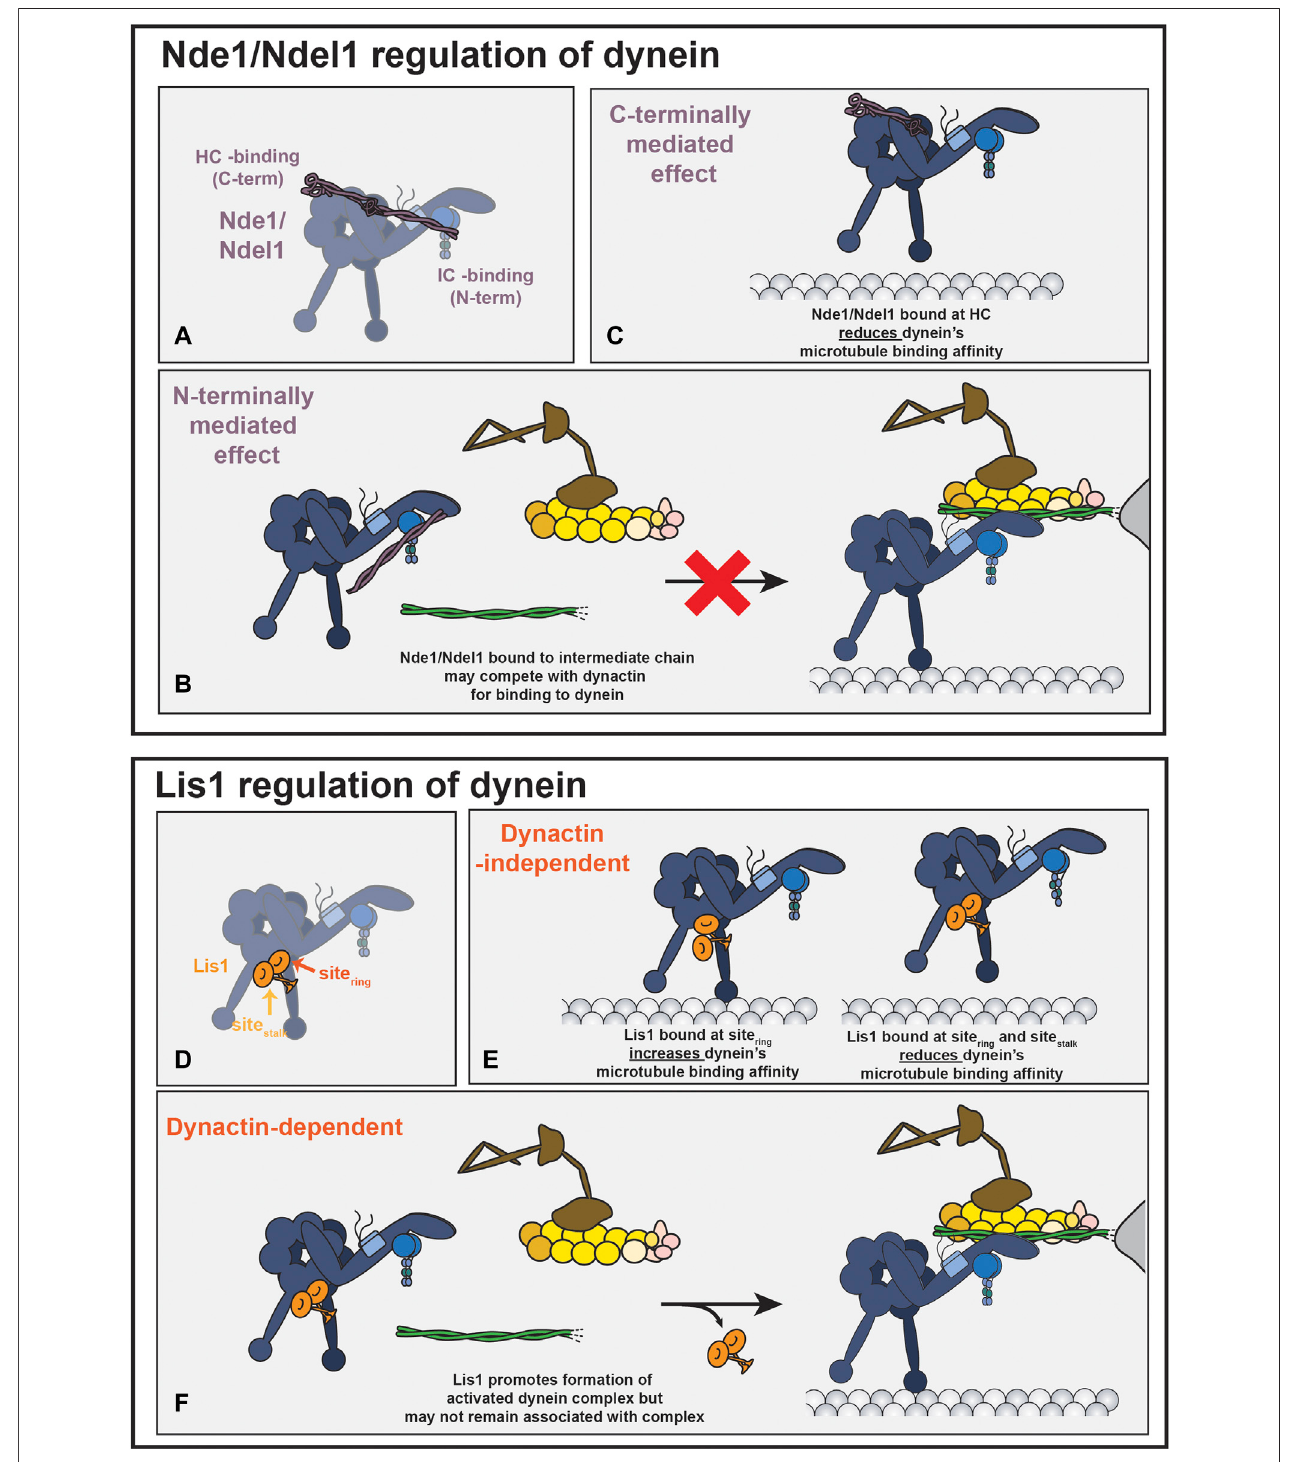
FIGURE 4 | Nde1/Ndel1 and Lis1 regulation of dynein. (A) Nde1/Ndel1, shown in purple, binds to up to three places on the dynein motor. The binding with the intermediate chain (IC) is mediated by Nde1/Ndel1 ’ s N-terminus and binding with the heavy chain (HC) is mediated by Ndel1 ’ s C-terminus (Liang et al., 2004; Sasaki et al., 2005;McKenney et al., 2011; Wang and Zheng, 2011; Ż y ł kiewicz et al., 2011; Nyarko et al., 2012; Wang et al.,2013).Binding between Nde1/Ndel1and dynein ’ s LC8 chain isnot shown (Stehman et al., 2007; McKenney et al., 2011). Although thisschematic shows Nde1/Ndel1 binding to both the intermediate chain and the heavy chain simultaneously, this has not been observed directly. (B) By binding competitively with dynactin for dynein ’ s intermediate chain, Nde1/Ndel1 ’ s N-terminus